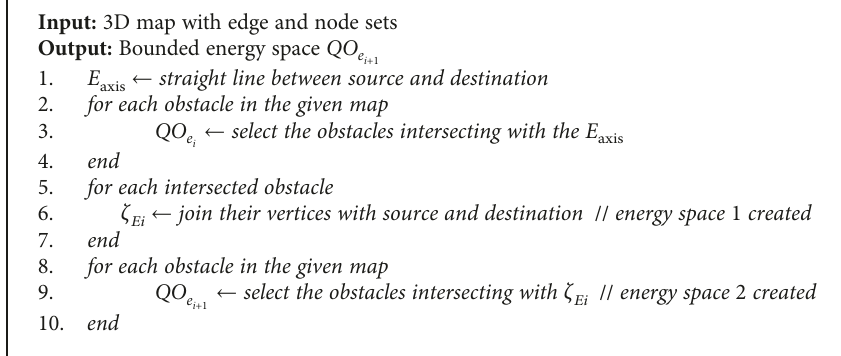
Algorithm 2. Bounded energy space selection Table 1: Roadmap construction processing time. Number of